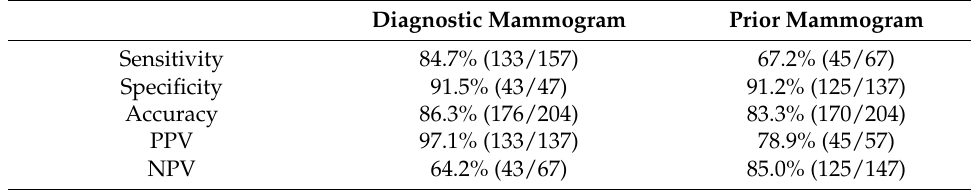
Table 3. Diagnostic performance of AI-CAD.